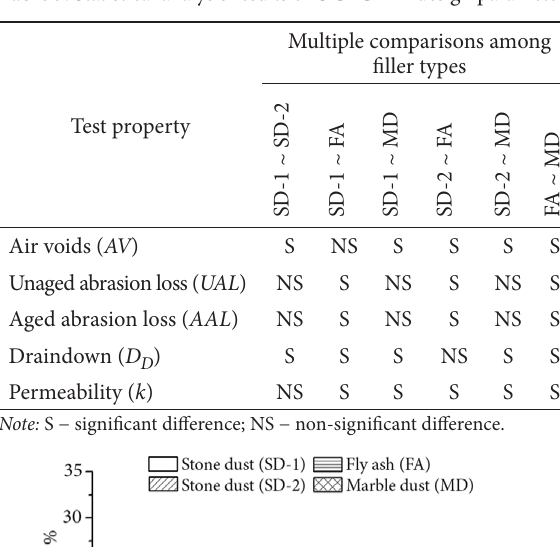
Fig. 6. Air voids of OGFC mixes Table 5. Statistical analysis results of OGFC mix design parameters